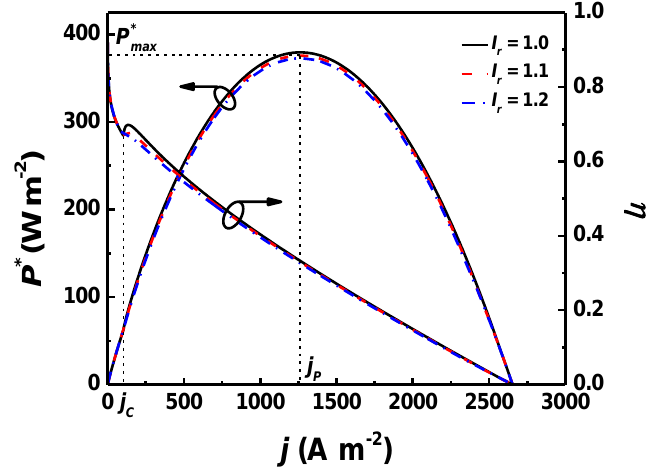
I on the hybrid system performance. Figure 3. Effects of the internal irreversibility I r on the hybrid system